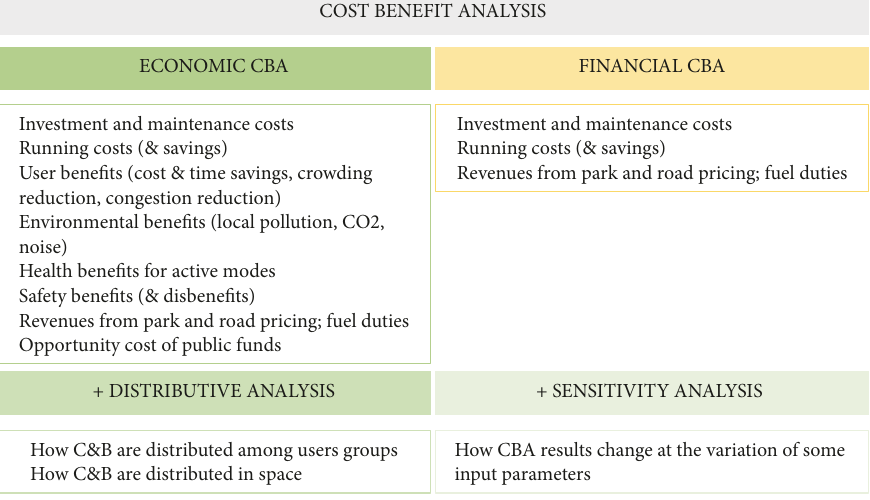
Figure 3: Cost-Benefit Analysis components.